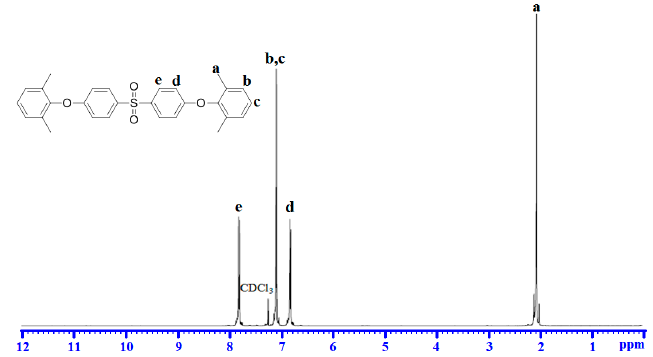
Figure 1. 1 H NMR of 4,4-(2,6-dimethylphenyloxy)diphenyl sulfone.